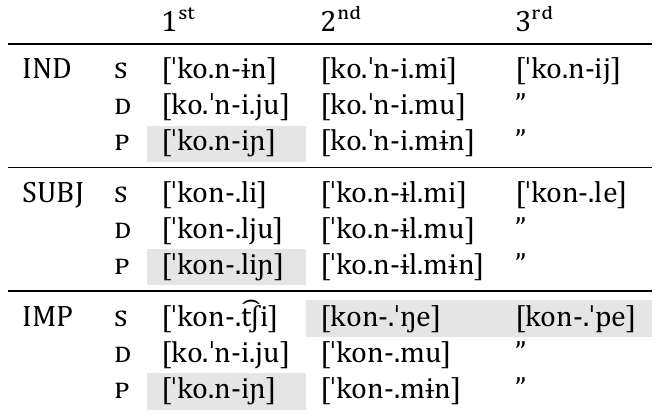
Table 10: Verbal paradigm for the consonant-(cid:976)inal root [kon-] ‘enter’, after Havestadt 1777 and Febrés 1765 (forms contradicting the ‘general rule’ shaded)